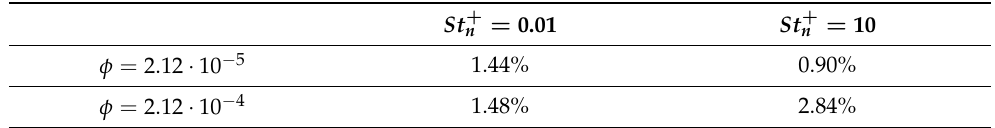
Figure 13. Mean streamwise fluid velocity along the wall-normal coordinate. The left panel refers to the φ = 2.12 · 10 − 5 case, the right panel refers to the φ = 2.12 · 10 − 4 case. The curves relative to the St + n = 0.01 fibers are plotted in blue while the curves relative to the St + n = 10 fibers are plotted in pink. The curve of the unladen flow case is plotted in dashed black for reference. All cases are normalized according to the shear velocity yield by the corresponding simulation. Table 1. Percentage of drag reduction, % DR (defined as in Equation (14)), for the different cases simulated in the ( φ , St + n ) parameter space considered in this study. Drag increase is obtained when % DR < 1, whereas drag reduction is obtained when % DR >